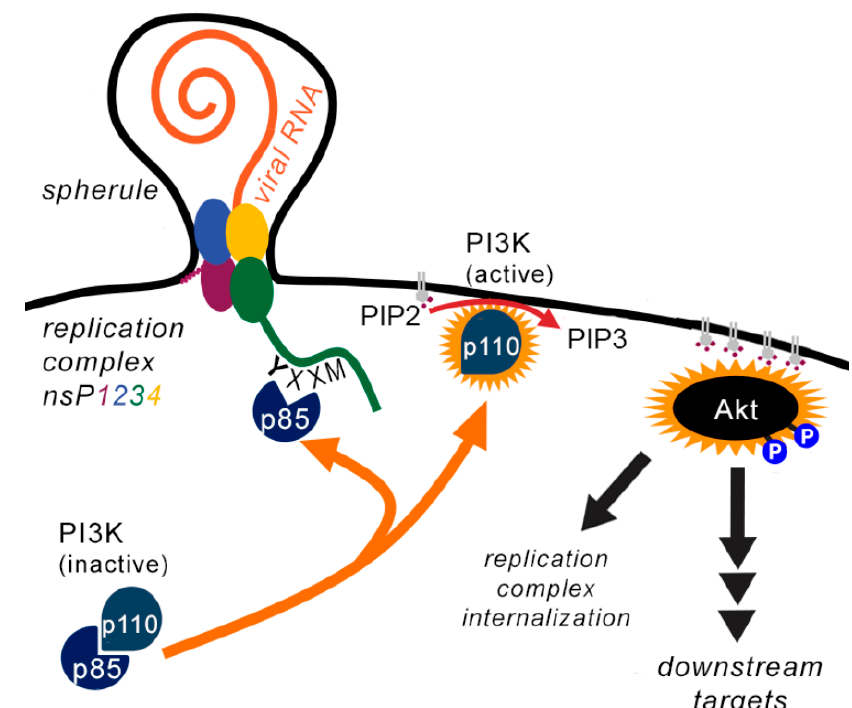
Figure 2. In Semliki Forest virus (SFV) and Ross River virus (RRV)-infected cells, viral replication complexes form at the PM. Via recruitment of p85 to a YXXM motif in nsP3, p110 is freed from regulation and can catalyse the conversion of PIP2 to PIP3 and recruitment and activation of AKT to the PM. Via multiple downstream effector pathways, the internalization of viral replication complexes as well as a heightened cellular metabolic activity and likely other yet undescribed states are promoted. For more details, see text.